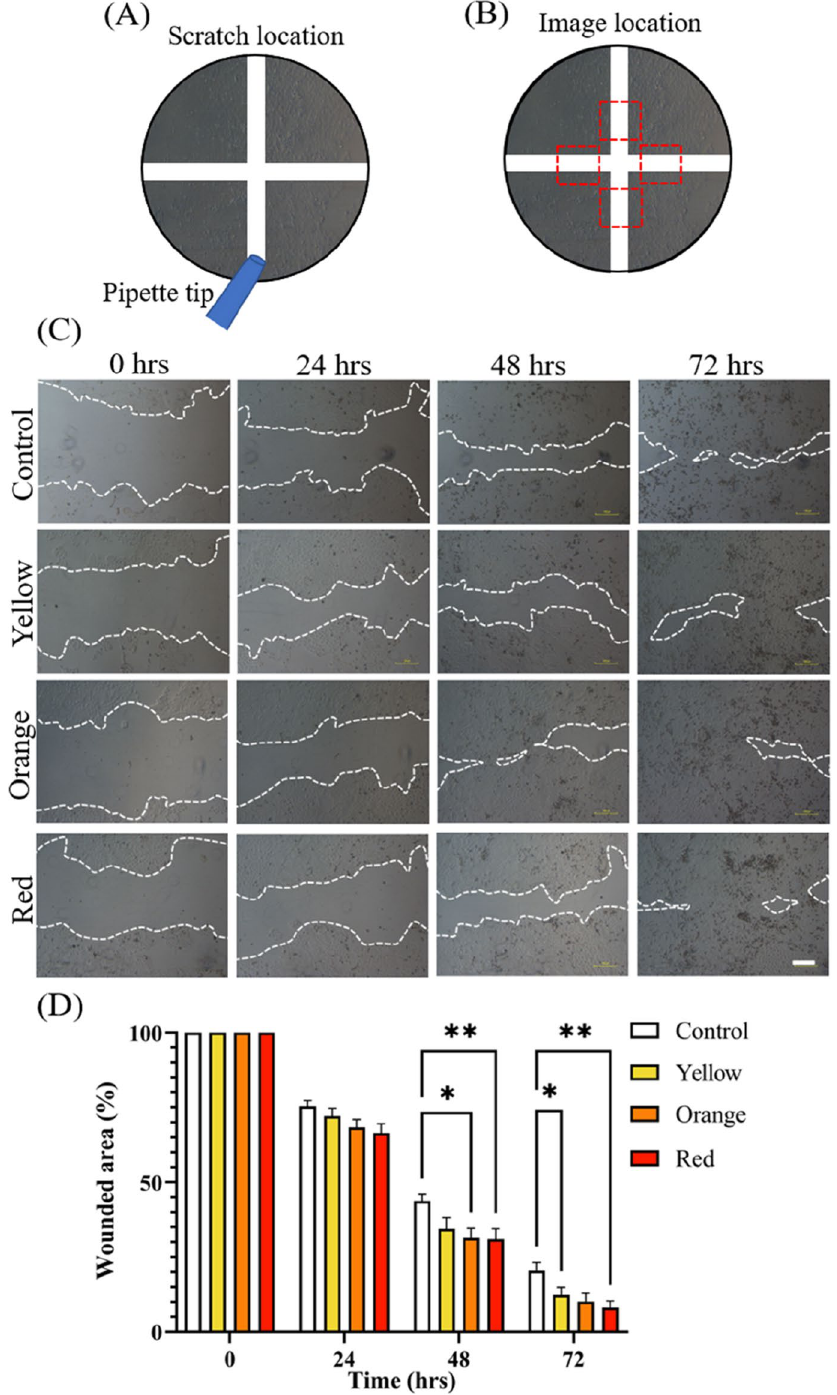
Figure 4. Measurement of HaCaT wound healing when exposed to visible light in in vitro scratch assay. ( A ) Schematic demonstrating location of the scratches made using a 1000 μl pipette tip. ( B ) Schematic highlighting location of images to both sides of the vertical scratch as indicated by the red boxes. ( C ) Representative images of wounded HaCaT monolayers for each visible light condition (red, orange, yellow) and control. Images captured at 0, 24, 48 and 72 h. Dotted lines define regions lacking cells. ( D ) Significant results observed between red light and control conditions at 48 and 72 h time points. Time 0 h is normalised to 1 and further time points are reflected as a portion of time 0 h. Images in 4c are representative images selected from two independent experiments. Scale bar in ( C ) represents 100 μm, error bars in D represent standard error, *P < 0.05, **P < 0.01, two-way ANOVA Tukey’s multiple comparisons